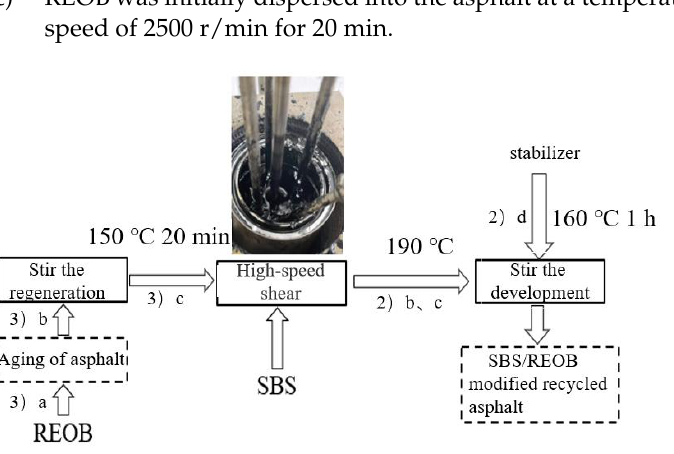
Figure 2. Preparation process of SBS/REOB-modified rejuvenated asphalt.